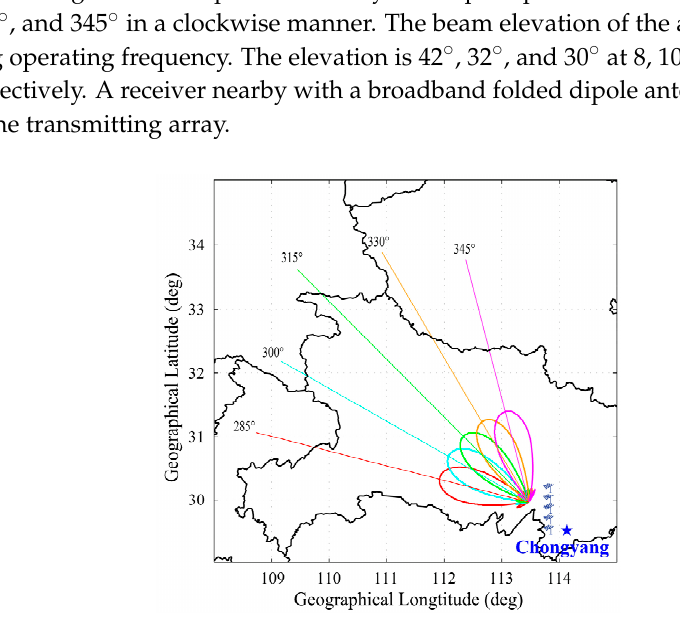
Figure 10. Map showing the location of the WIOBSS-AA in Chongyang, Hubei province, China and the antenna pointing in the experiment of 16 March 2015. The five main beams of the WIOBSS-AA are denoted by the different